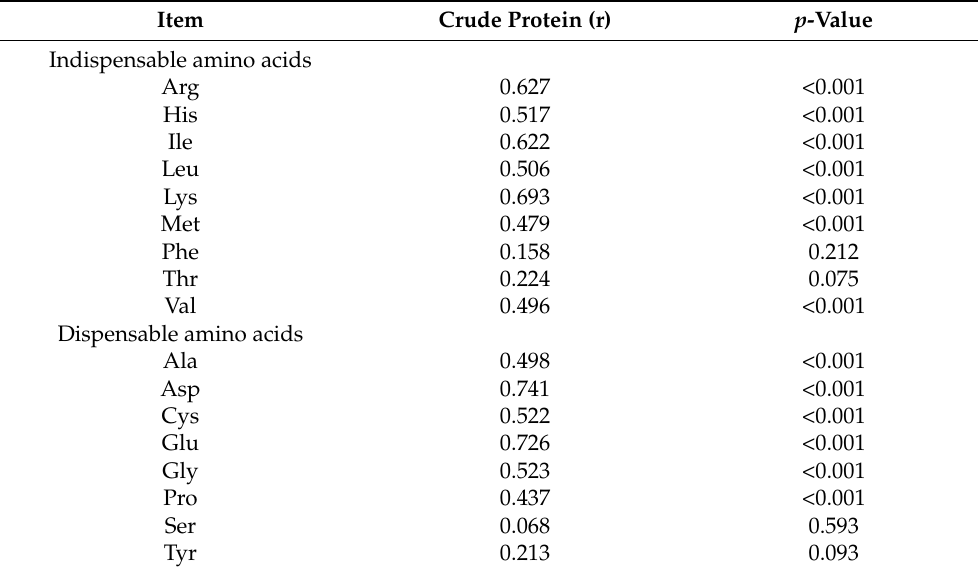
Table 3. Correlation coefficients (r) between crude protein and amino acid concentrations (% on a dry matter basis) 1 .